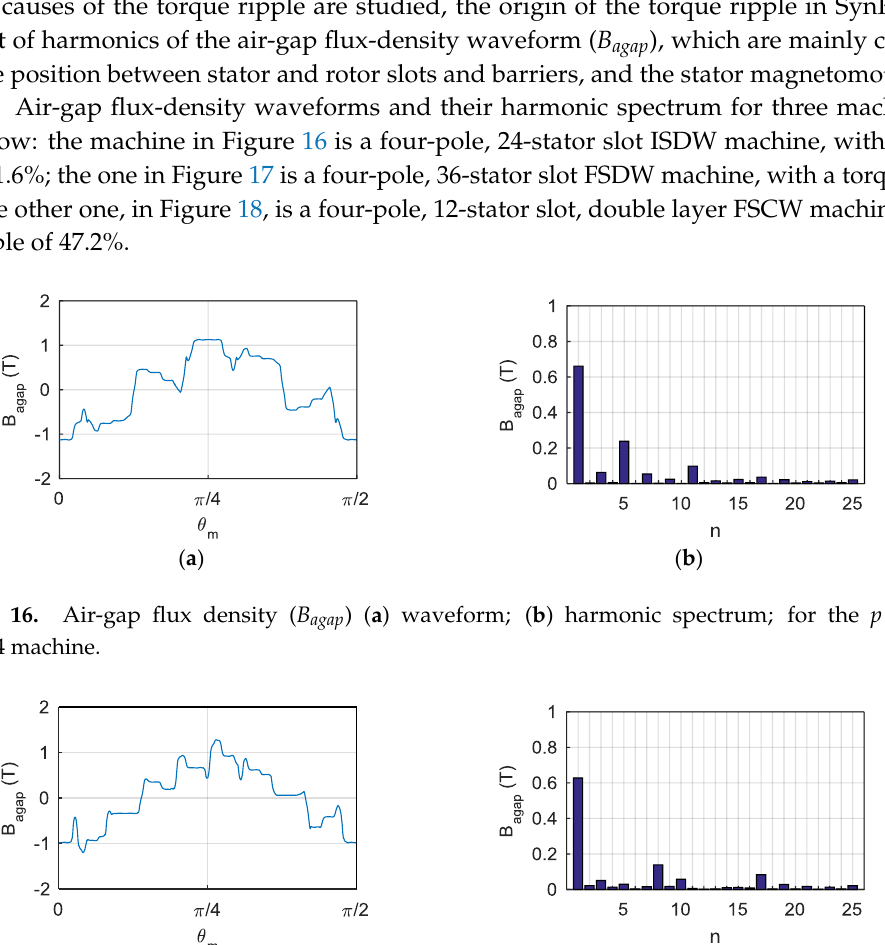
Figure 17. Air-gap flux density ( B agap ) ( a ) waveform; ( b ) harmonic spectrum; for the p = 4, Q s = 36 machine.